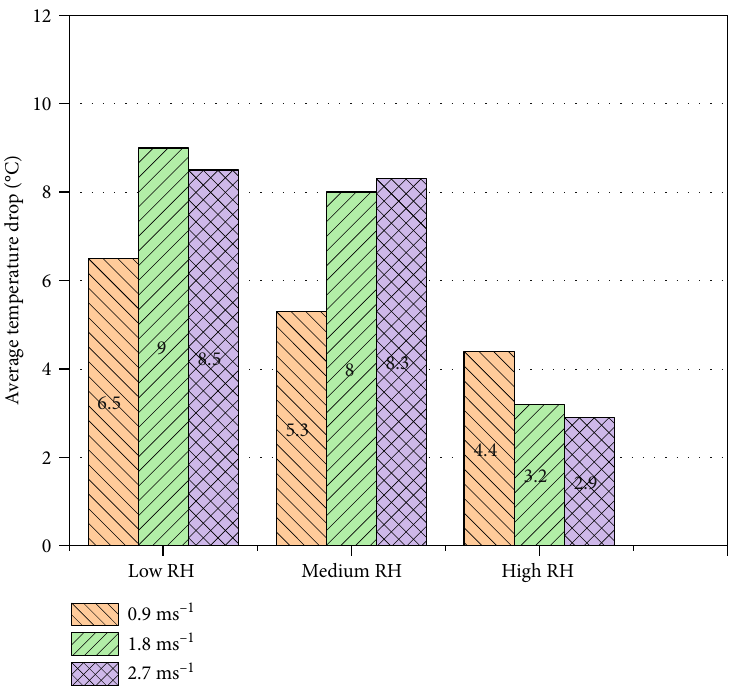
Figure 10: Average temperature drop of the air from the air cooler at three di ff erent velocities under three di ff erent RH